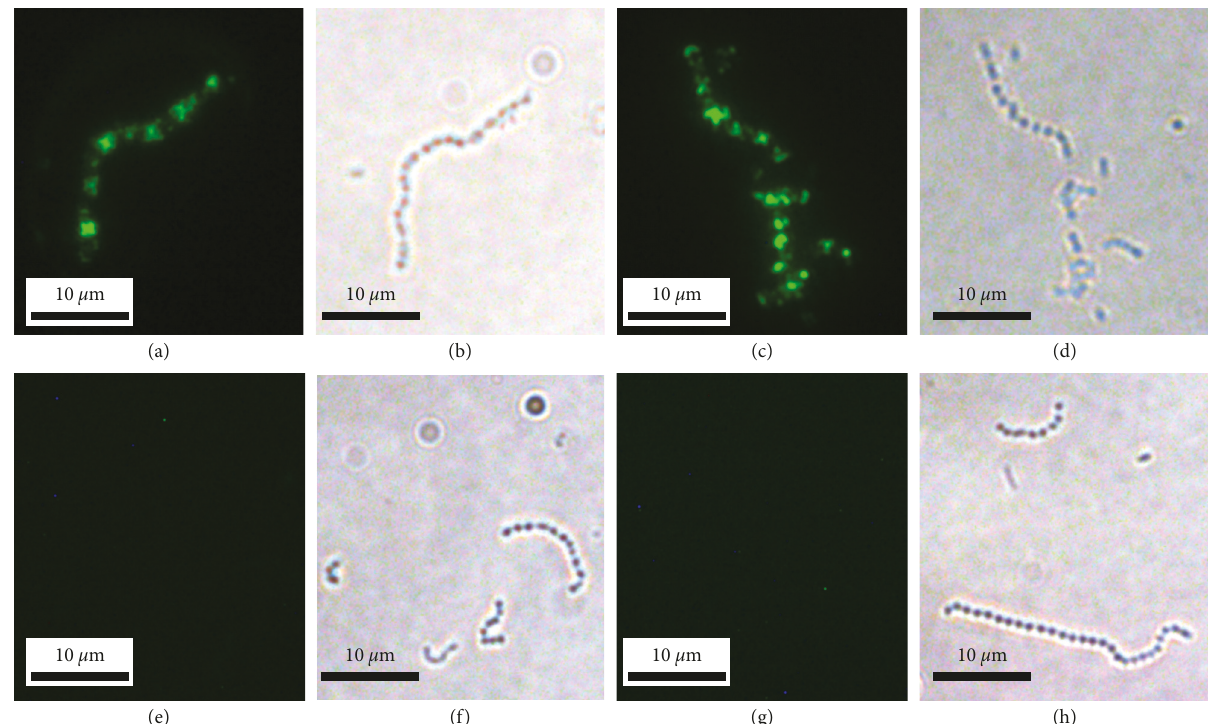
Figure 3: Photomicrographs of DyLight 488-stained M1 and M12 GAS. (a) M1 GAS exposed to antisera of immunized group mice. (b) Bright- field view of (a). (c) M12 GAS exposed to antisera of immunized group mice. (d) Bright-field view of (c). (e) M1 GAS exposed to antisera of control group mice. (f) Bright-field view of (e). (g) M12 GAS exposed to antisera of control group mice. (h) Bright-field view of (g).